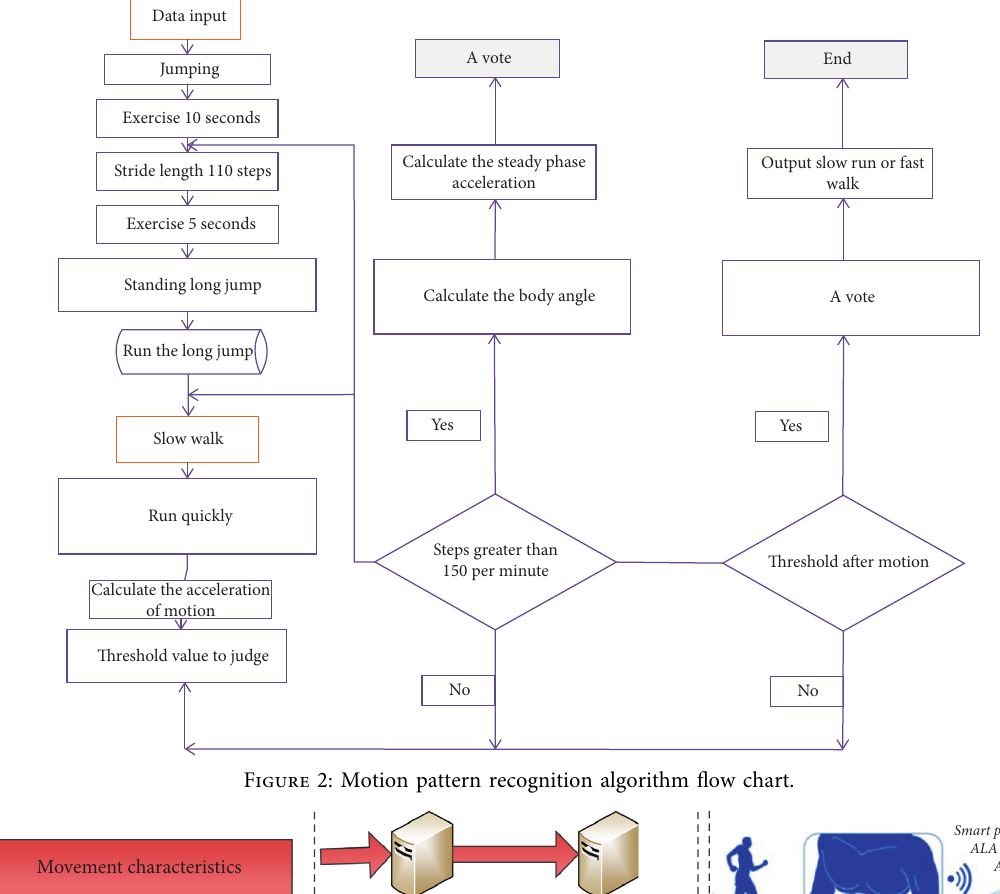
Figure 2: Motion pattern recognition algorithm flow